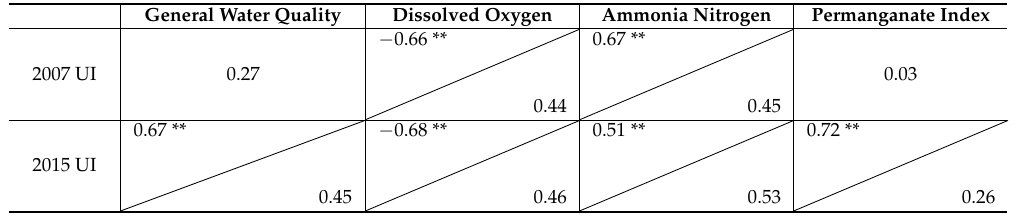
Table 4. Correlation coefficients (Pearson’s r) of I URB and water quality